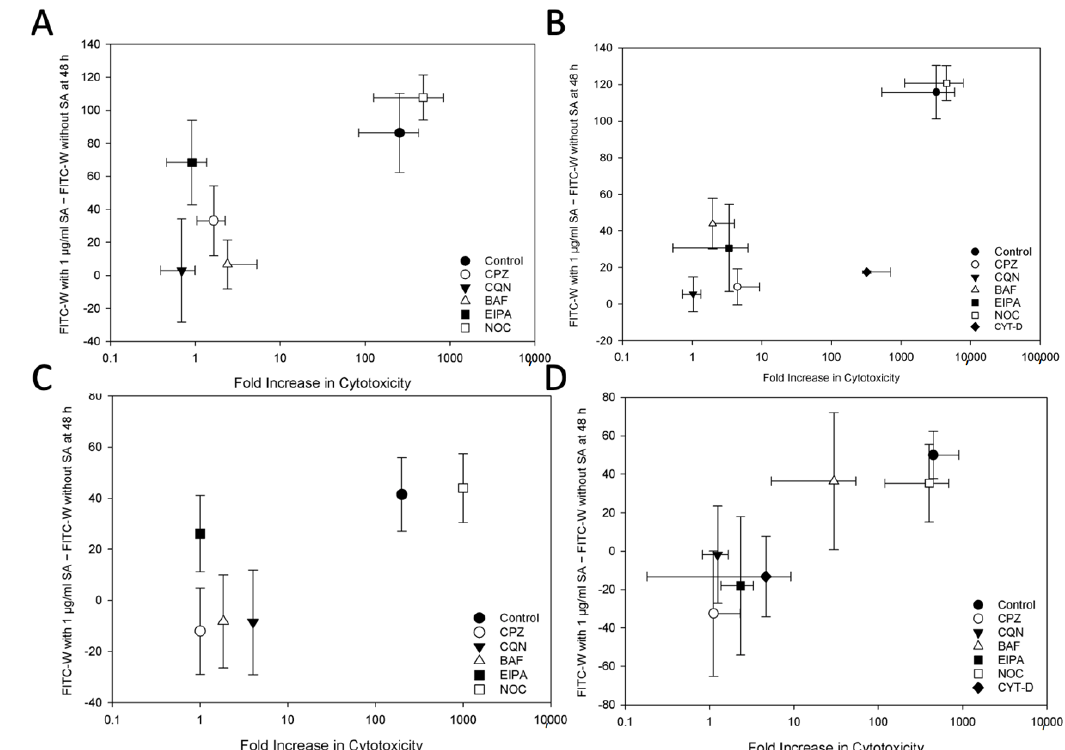
Figure 6. Correlation between the effect of pharmacological agents on the SA-Mediated augmentation of saporin and OKT10-SAP cytotoxicity and on the SA-mediated Increase in endolysosomal escape of SAP-AF and OKSAP-AF. Scatter graphs comparing the SA-mediated fold increase in cytoxicity versus the SA-mediated difference in FITC-W after 48 h of exposure to 1 µg/mL. ( A , B ) show the data for Daudi cells with OKT10-SAP/OKSAP-AF and saporin/SAP-AF, respectively, with ( C , D ) showing the data for HSB-2 cells with OKT10-SAP/OKSAP-AF and saporin/SAP-AF, respectively. Each data point shows the mean fold increase in cytotoxicity from four independent XTT assays and the mean difference in FITC-W from three independent flow cytometry studies with each inhibitor and untreated controls included for comparison. These experiments were not paired. Error bars represent the standard deviation from the mean. No error bars are presented for the fold increase in cytotoxicity for OKT10-SAP on HSB-2 cells ( C ) as an EC50 was achieved in only some of the experiments performed. CPZ: chlorpromazine; CQN: chloroquine; BAF: bafilomycin A1; CYT-D: cytochalasin D; NOC: nocadazole.